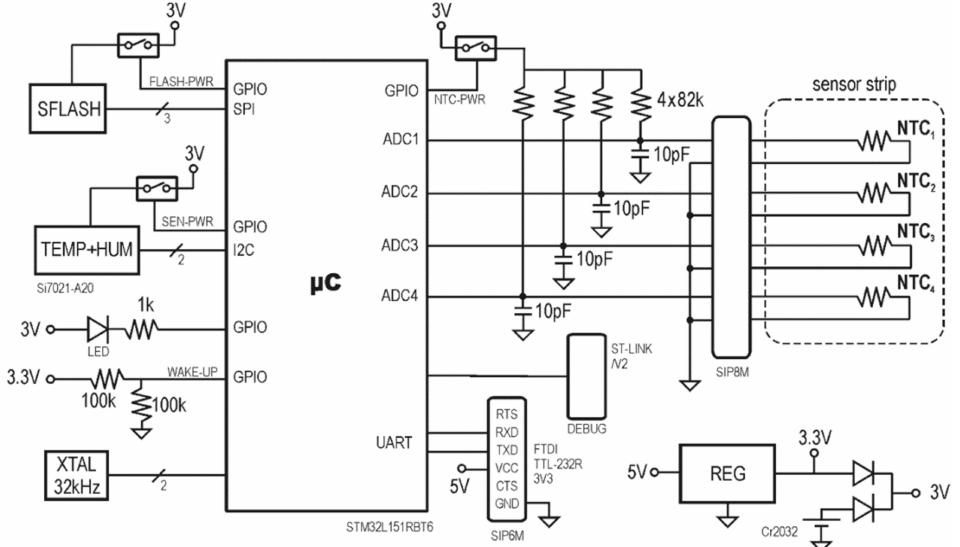
Figure A2. Schematic of the electronic system for temperature measurement. Four analog channels of the microcontroller acquire voltage from the multisensor NTC thermistors. An I2C-communicated (I2C, Inter-Integrated Circuit) sensor (Si7021) sends the external temperature and humidity. A USB interface (through an external FTDI converter) provides communication with PC for data transmission. Autonomous lifetime is ensured by disconnecting devices in sleep mode when